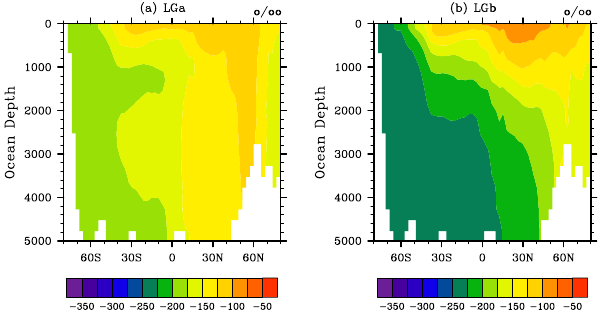
Fig. 5. (a) Atlantic 1 14 C (‰) in LGa. (b) as in (a) , but for in